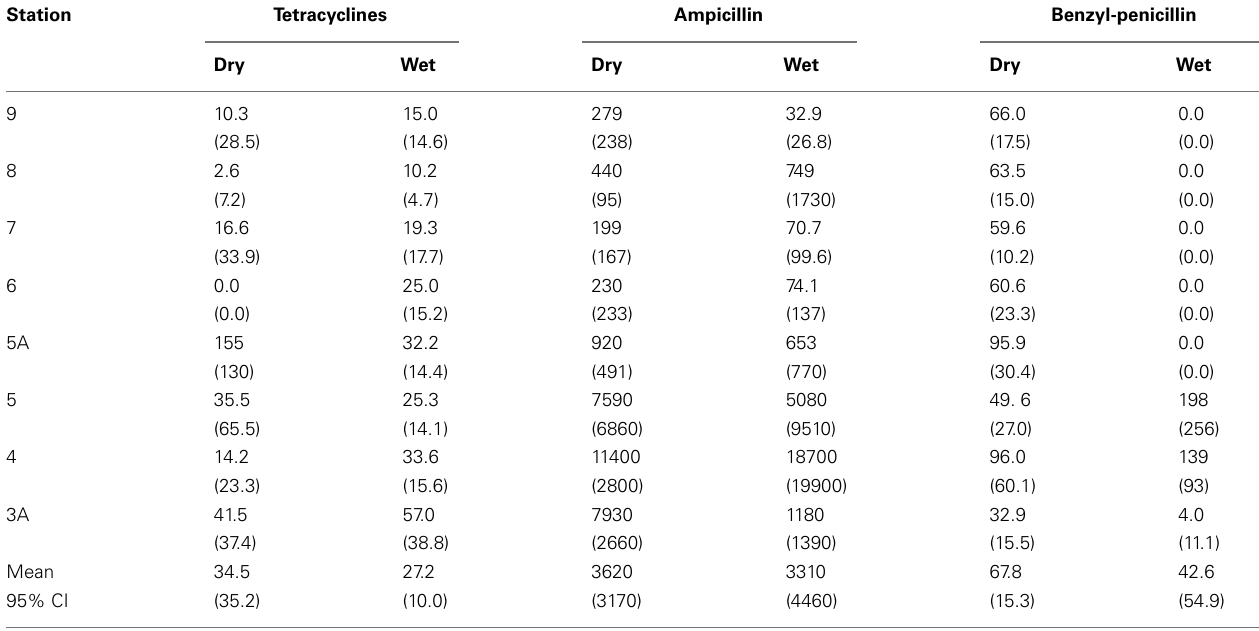
TableA6 |Antibiotic residue concentrations in the water column at sampling stations along theAlmendares River in ppt.